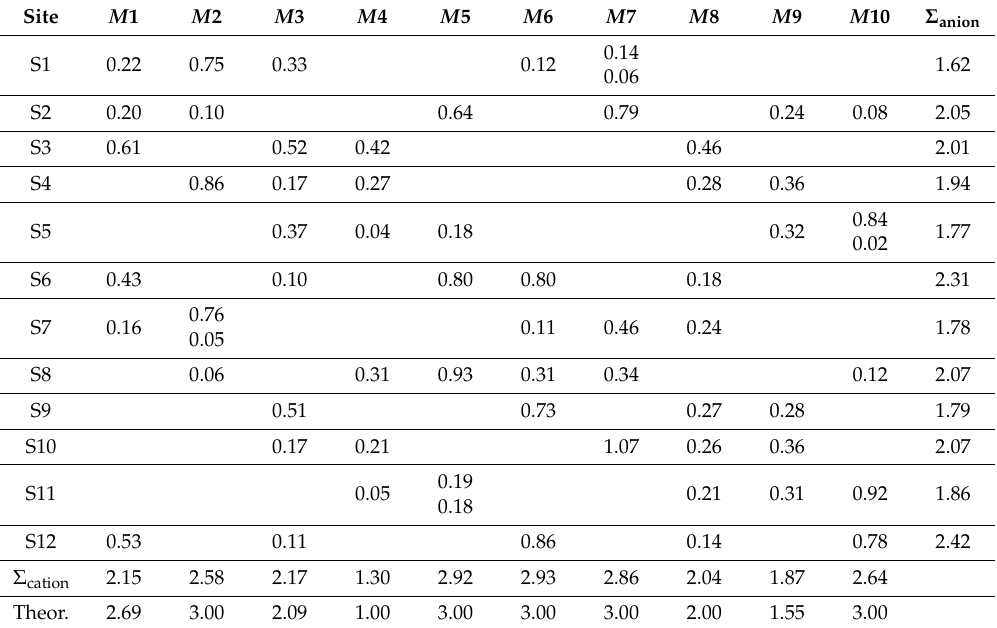
Table 5. Bond valence sums (in valence unit) in